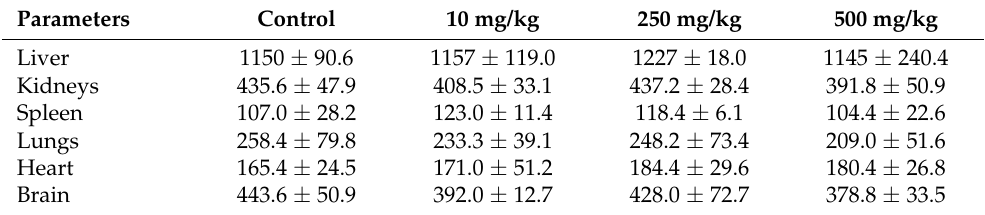
Table 2. Relative organ weight (mean ± SD) of PsA versus control-treated female Swiss albino mice. After being excised, intact organs were dabbed with a cloth to remove excess blood and immediately weighed. Kidneys and lungs were weighed together. Data shown as mean ± SD for n = 5/sex/group.